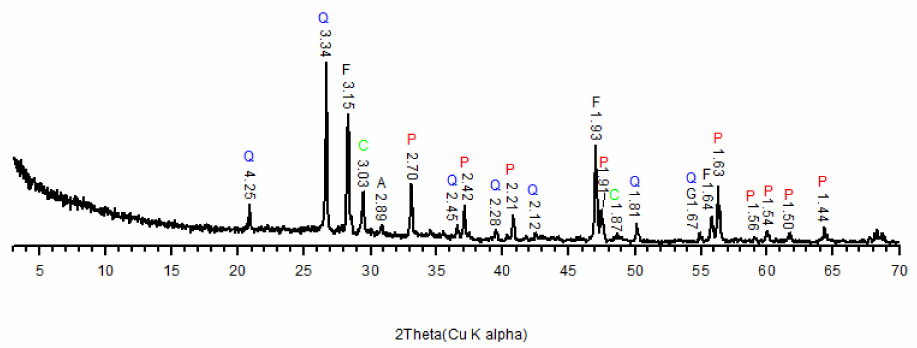
Figure 2. X-ray di ff raction (XRD) patterns of the raw concentrate. A: adularia; C: calcite; F: fluorspar; P: pyrite; Q: